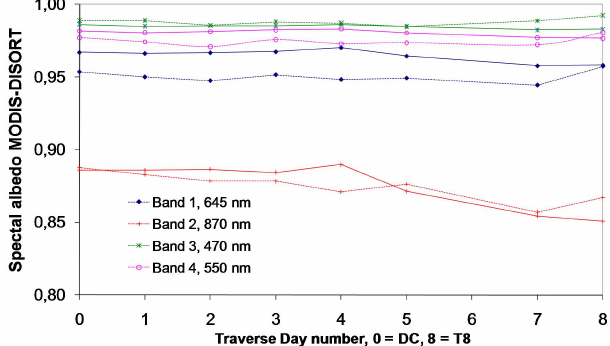
Fig. 16. Spatial variations of the spectral albedo during the traverse. Data shown compare values obtained for MODIS bands 1 to 4, with those calculated for the same wavelengths using DISORT and our snow SSA and density profiles (solid lines).